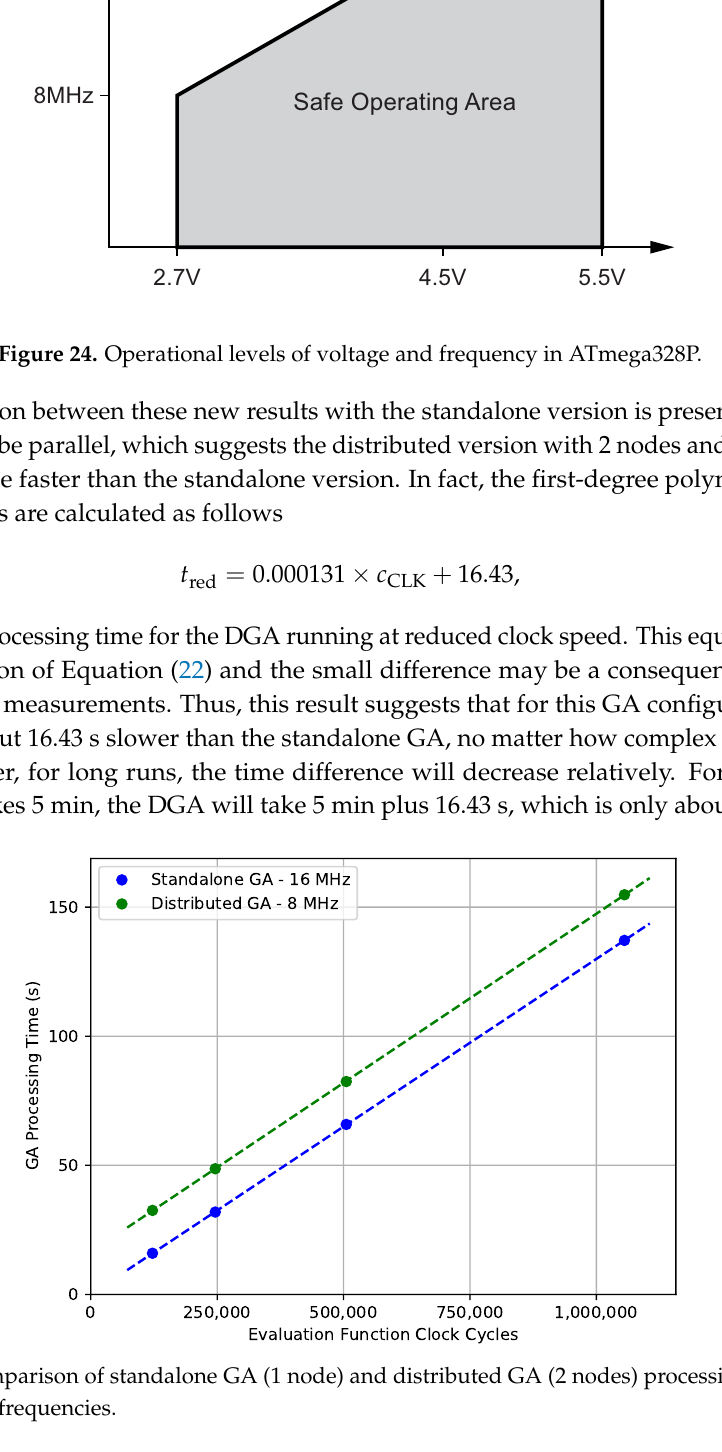
Figure 28-1. Maximum Frequency